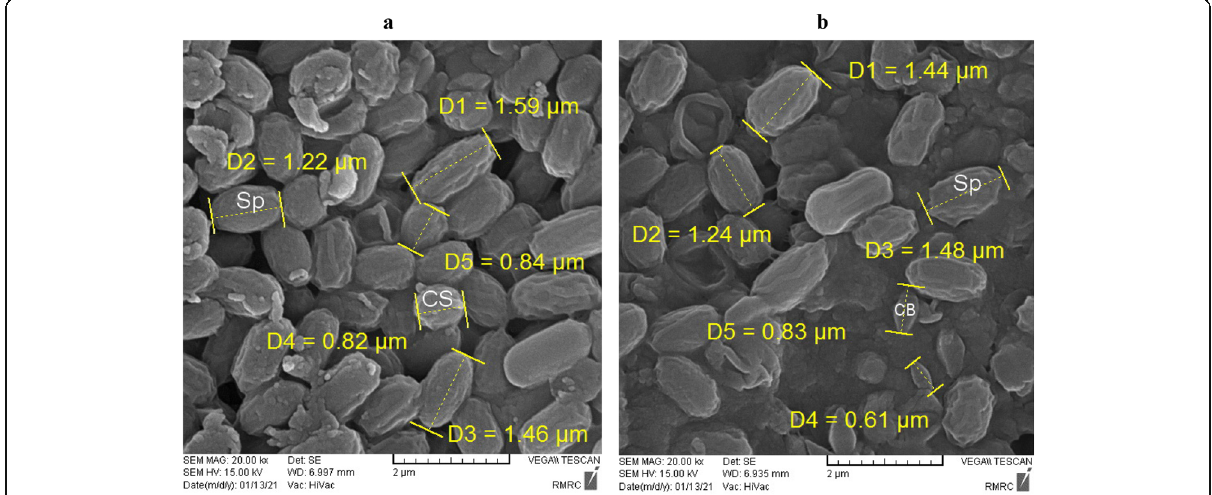
Fig. 1 Scanning electron microscopy of parasporal crystals and spores from the 1019 strain. a CS , spherical and b CB , bipyramidal; Sp , spore, C ,